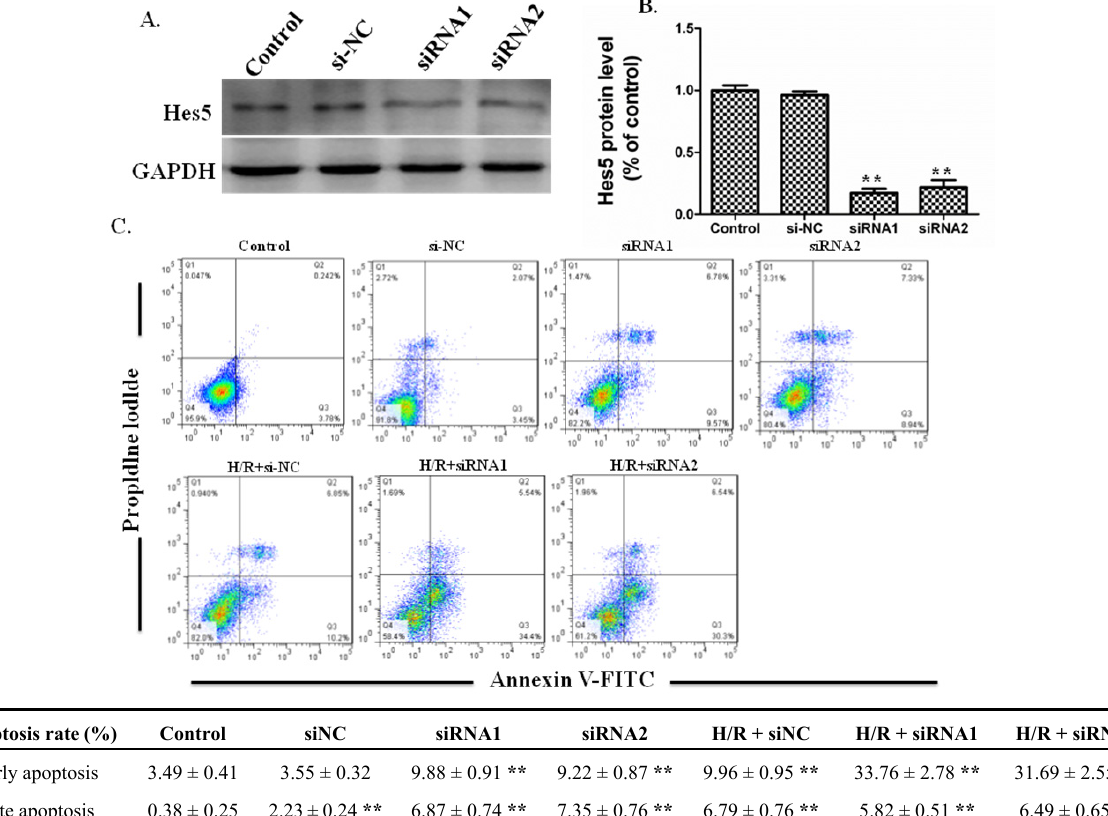
Figure 5. siRNA for Hes5 increased apoptosis of IEC-6 cells receiving H/R. ( A ) Cells were plated onto 6-well plates. Inhibition of Hes5 with siRNA was carried out as mentioned in the materials and methods part. After 48 h of culture, protein was extracted from IEC-6 hcells plated on 6-well plates. Western blot analysis showed that siRNA for Hes5 down-regulated protein expression of Hes5 compared to the si-NC or control group. GAPDH was used as loading control; ( B ) Graphic representation of relative expression of Hes5 normalized to GAPDH. Data are given as the means ± SDs ( n = 5). ** p < 0.01 vs. control group; ( C ) Flow cytometry was applied to examine the apoptosis of IEC-6 cells with apoptosis markers (FITC-Annexin V and PI). In the apoptosis map, FITC-Annexin V+/PI+ indicates late apoptosis, FITC-Annexin V+/PI − indicate early apoptosis, and FITC-Annexin V − /PI − indicate normal live cells. SiRNA1 and siRNA2 all increased